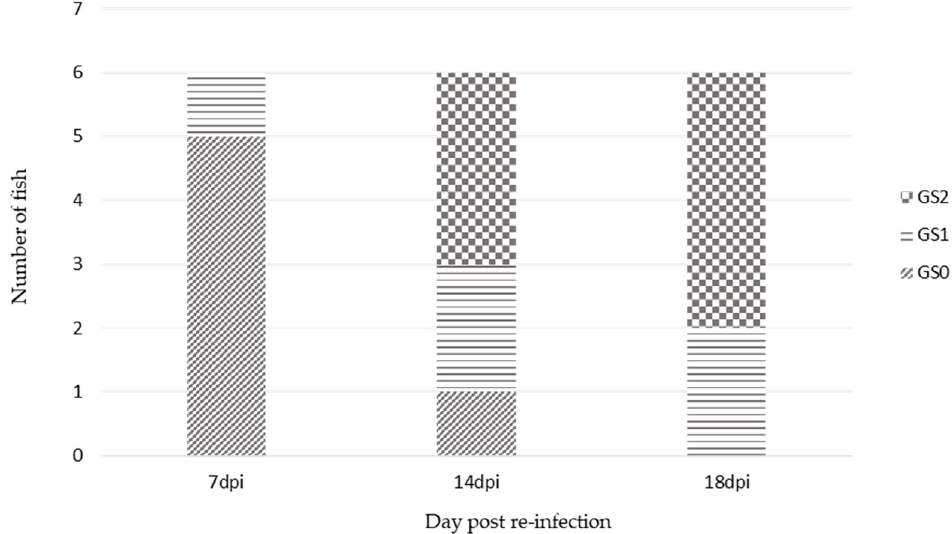
Figure 2. Distribution of gill scores from fish sampled 7 days (T2), 14 days (T3), and 18 days (T4) post re-infection.